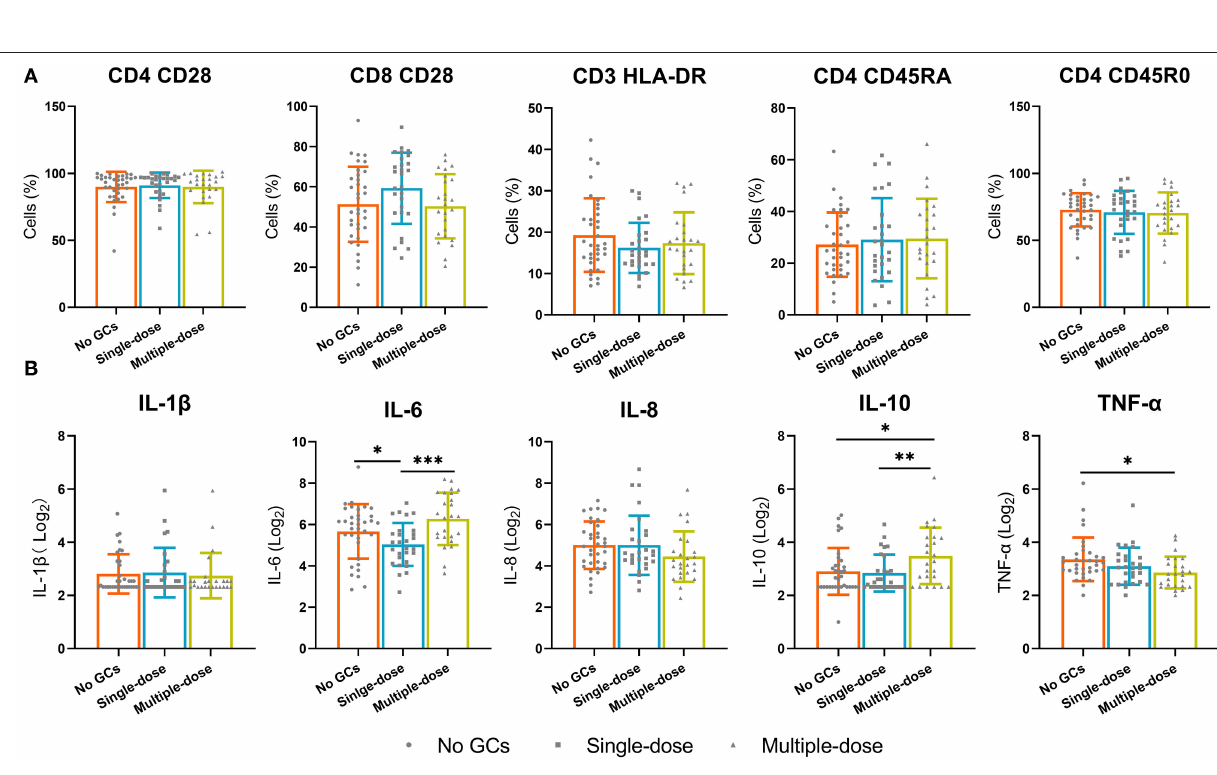
Frontiers in Surgery |